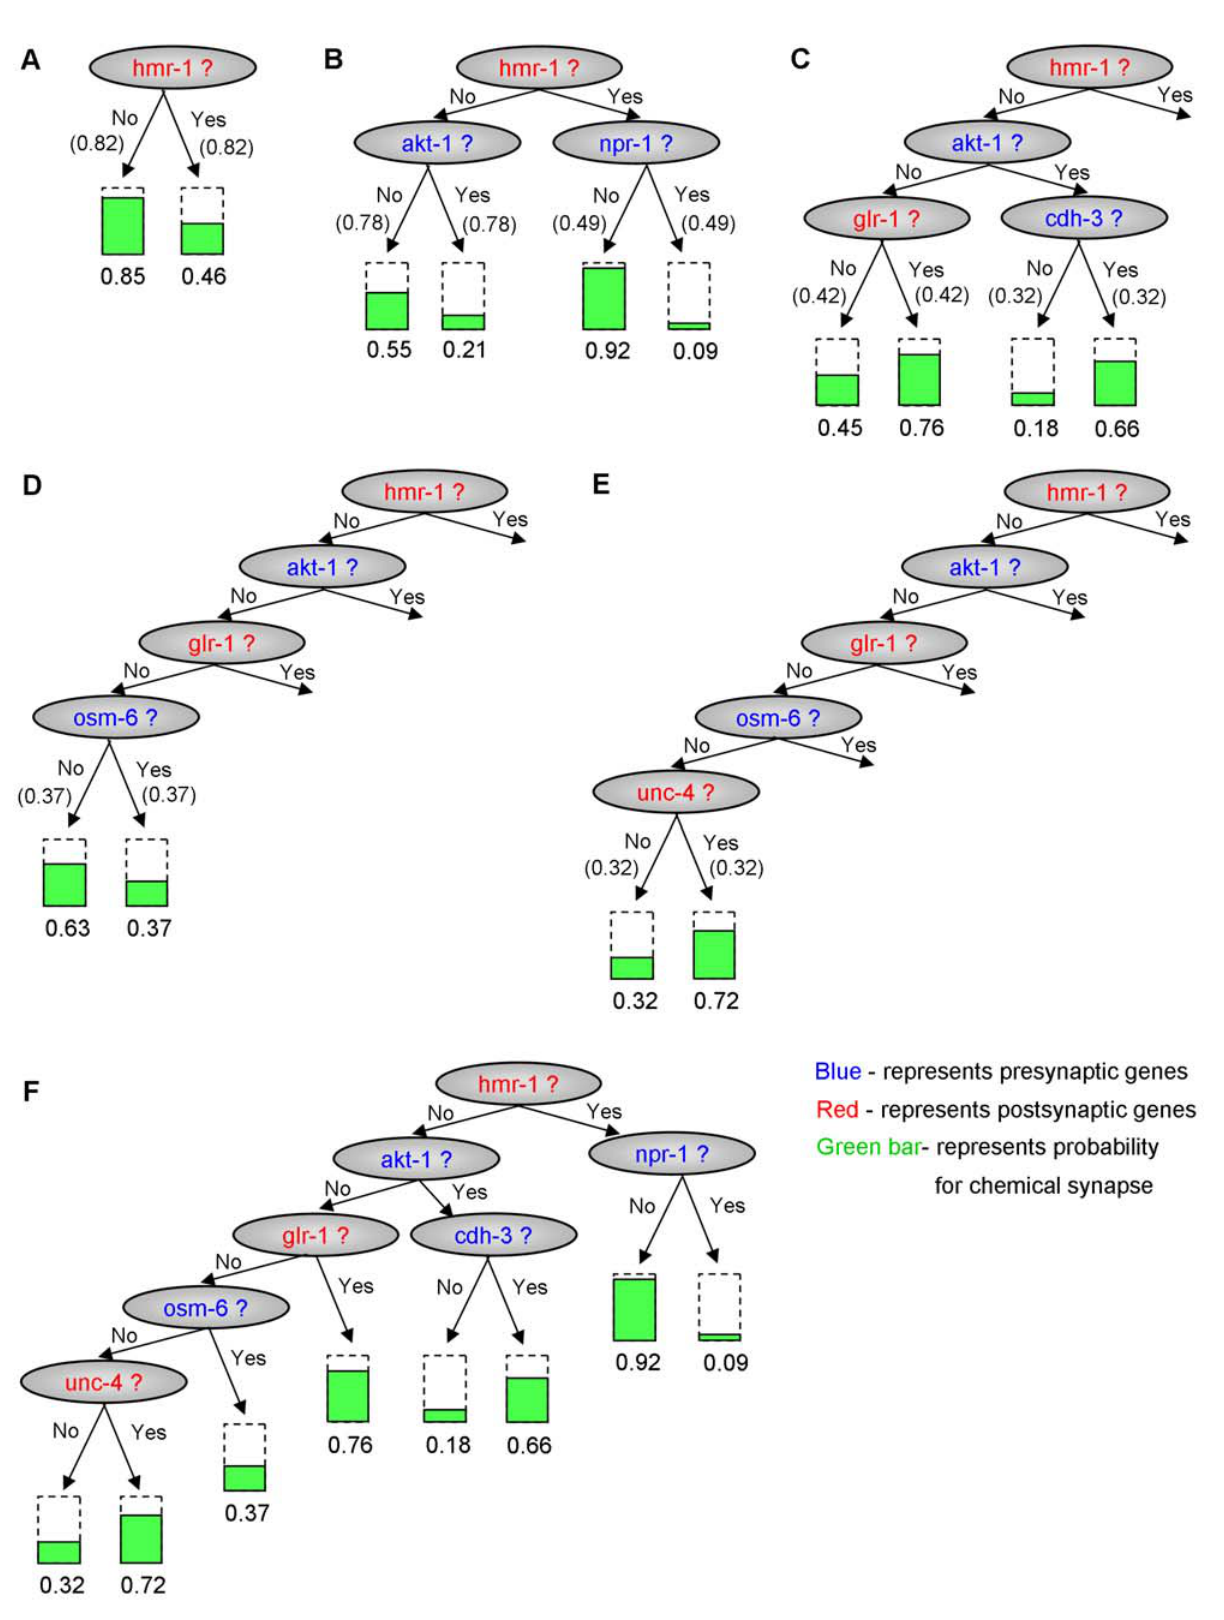
Figure 4. The Highest Confidence Rules That Were Learned in Bootstrap of Tree-CPDs. The highest confidence rules that were learned in bootstrap of tree-CPDs of maximal depth of one (A), two (B), three (C), four (D), and five (E). The confidence of each rule is written in parentheses. (F) The final, most confident, tree-CPD for the chemical synapse. This tree was constructed by combining the rules from (A–E).